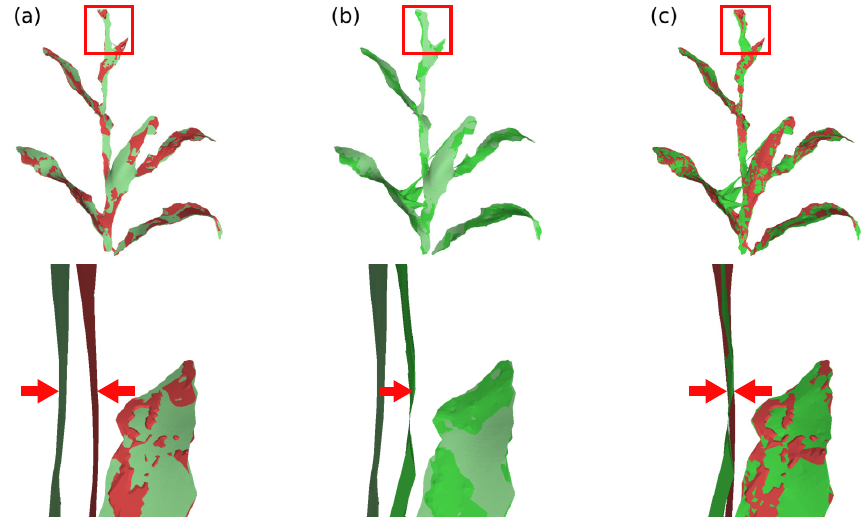
Figure 11. Model deformation in plant’s stem region. ( a ) Difference of the plant’s stem position between the model deformation graph (green) and the input surface deformation graph (red), during processing between frames 30 and 40; ( b ) deformation of the model surface and ( c ) comparison between deformed model surface (green) and input surface (red).